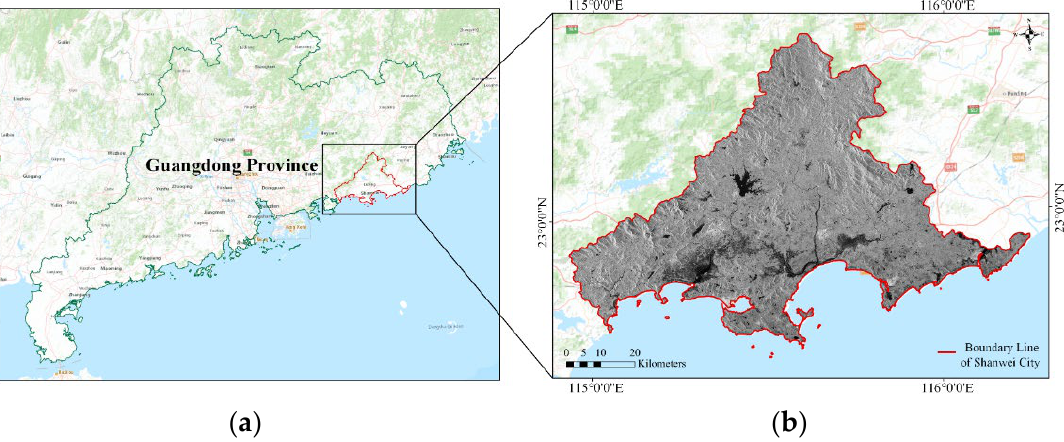
Figure 1. ( a ) Geographical location of the study area. ( b ) SAR time series data covering the study area.